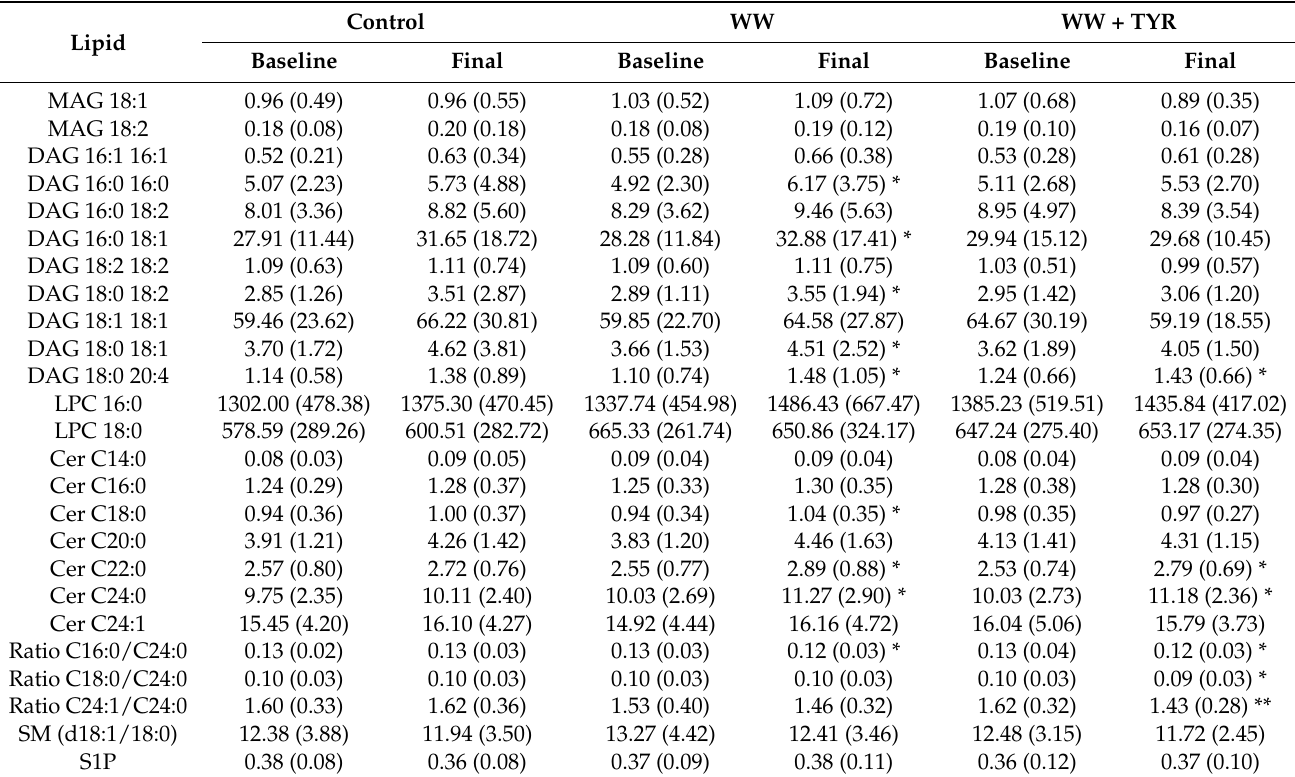
Table 1. Effects in the lipidomic profile of the 4-week control, WW, and WW + TYR